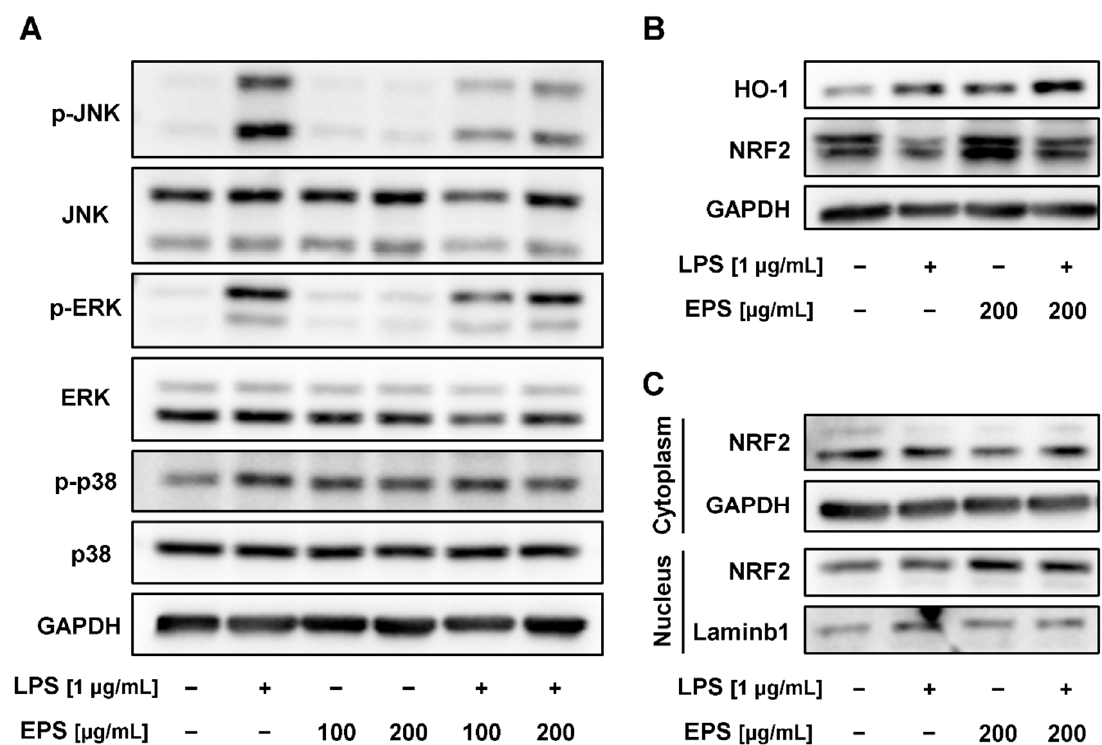
Figure 6. EPS regulated mitogen-activated protein kinase (MAPK) and Nuclear factor E2-related factor 2 (NRF2) / Heme oxygenase-1 (HO-1) pathways known as major pathways mediating the inflammatory response. ( A ) To determine that EPS could inhibit the MAPK pathway in LPS-induced RAW 264.7 cells, the phosphorylation in MAPK family proteins was analyzed through Western blot. The result showed that EPS inhibited the phosphorylation of JNK and ERK induced by LPS, although that of p38 was less inhibited. ( B ) Expression of both HO-1 and NFR2 was upregulated with or without the presence of LPS. ( C ) EPS stimulated the translocation of NRF2 into the nucleus.